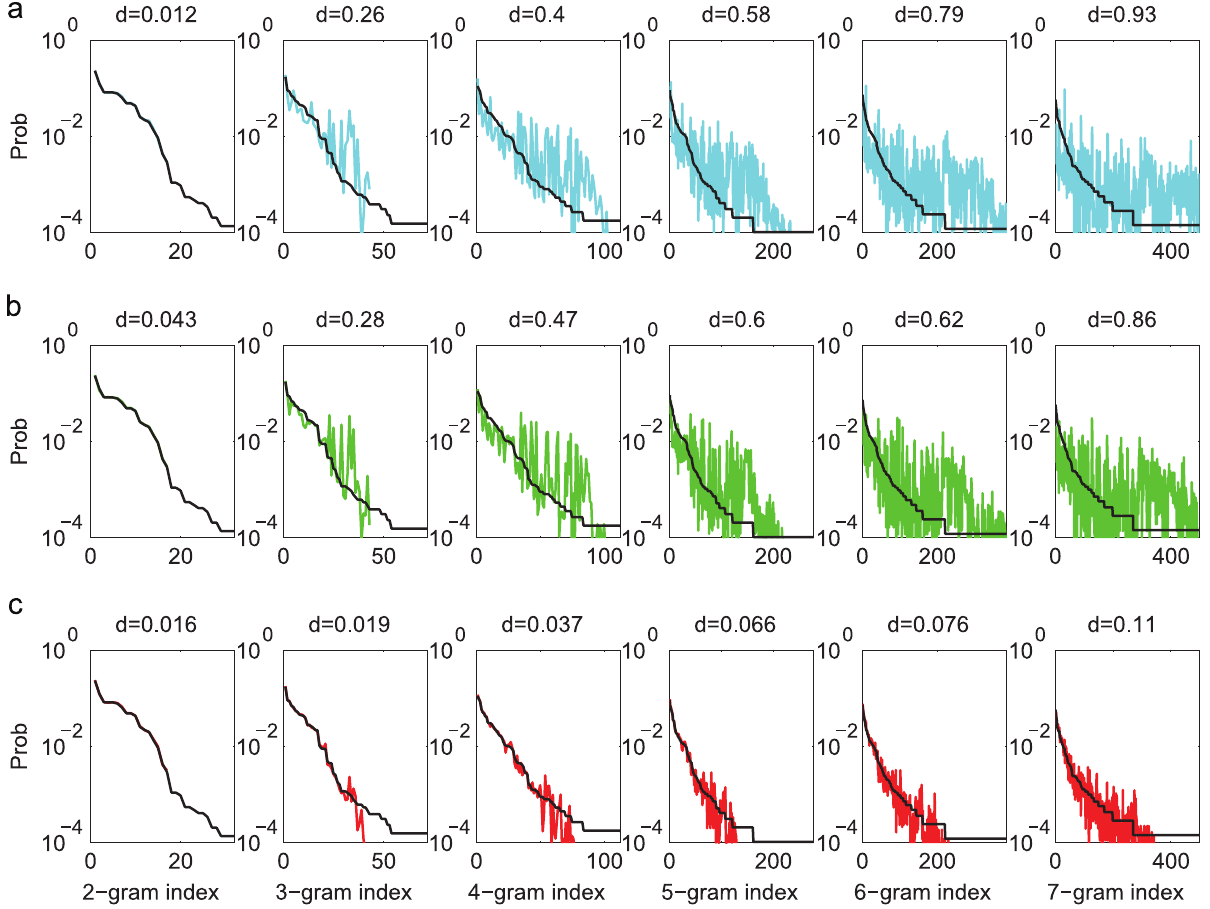
Figure 4. Comparisons of the N-gram distributions (Bird 1). a . The Markov model. b . The Markov model with adaptation. c . The POMMA. The conventions are the same as in Figure 3.